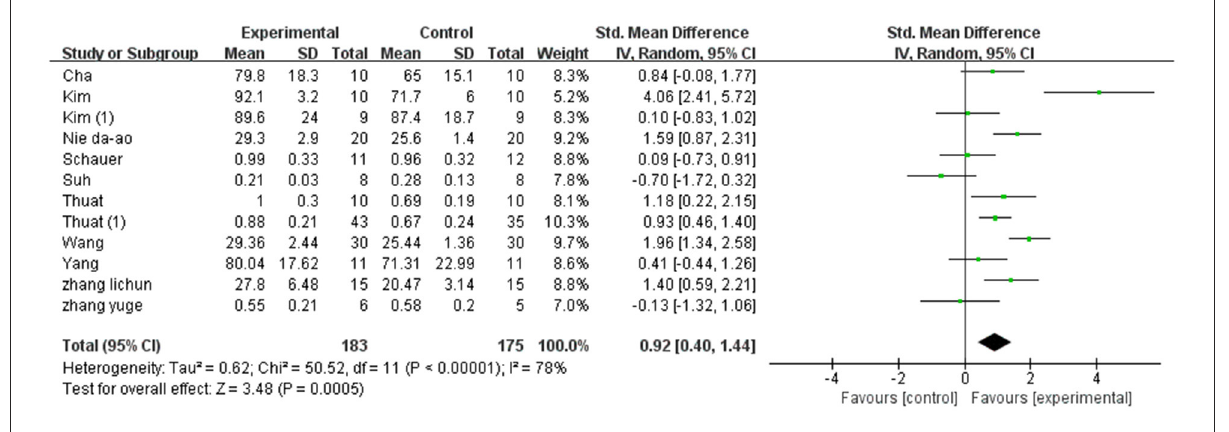
FIGURE4 Forest plot of step length for meta-analysis.